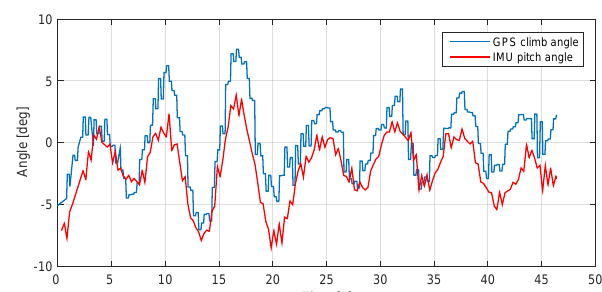
Figure 7. Example of the GPS climb angle and the IMU pitch angle after applying a time shift of 1.2s to the IMU, for one single leg (about 1km length) of flight no.